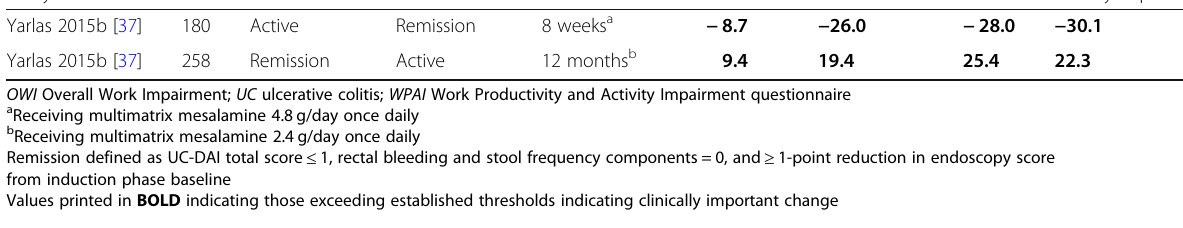
Change in mean WPAI scores from Time 1 to Time 2